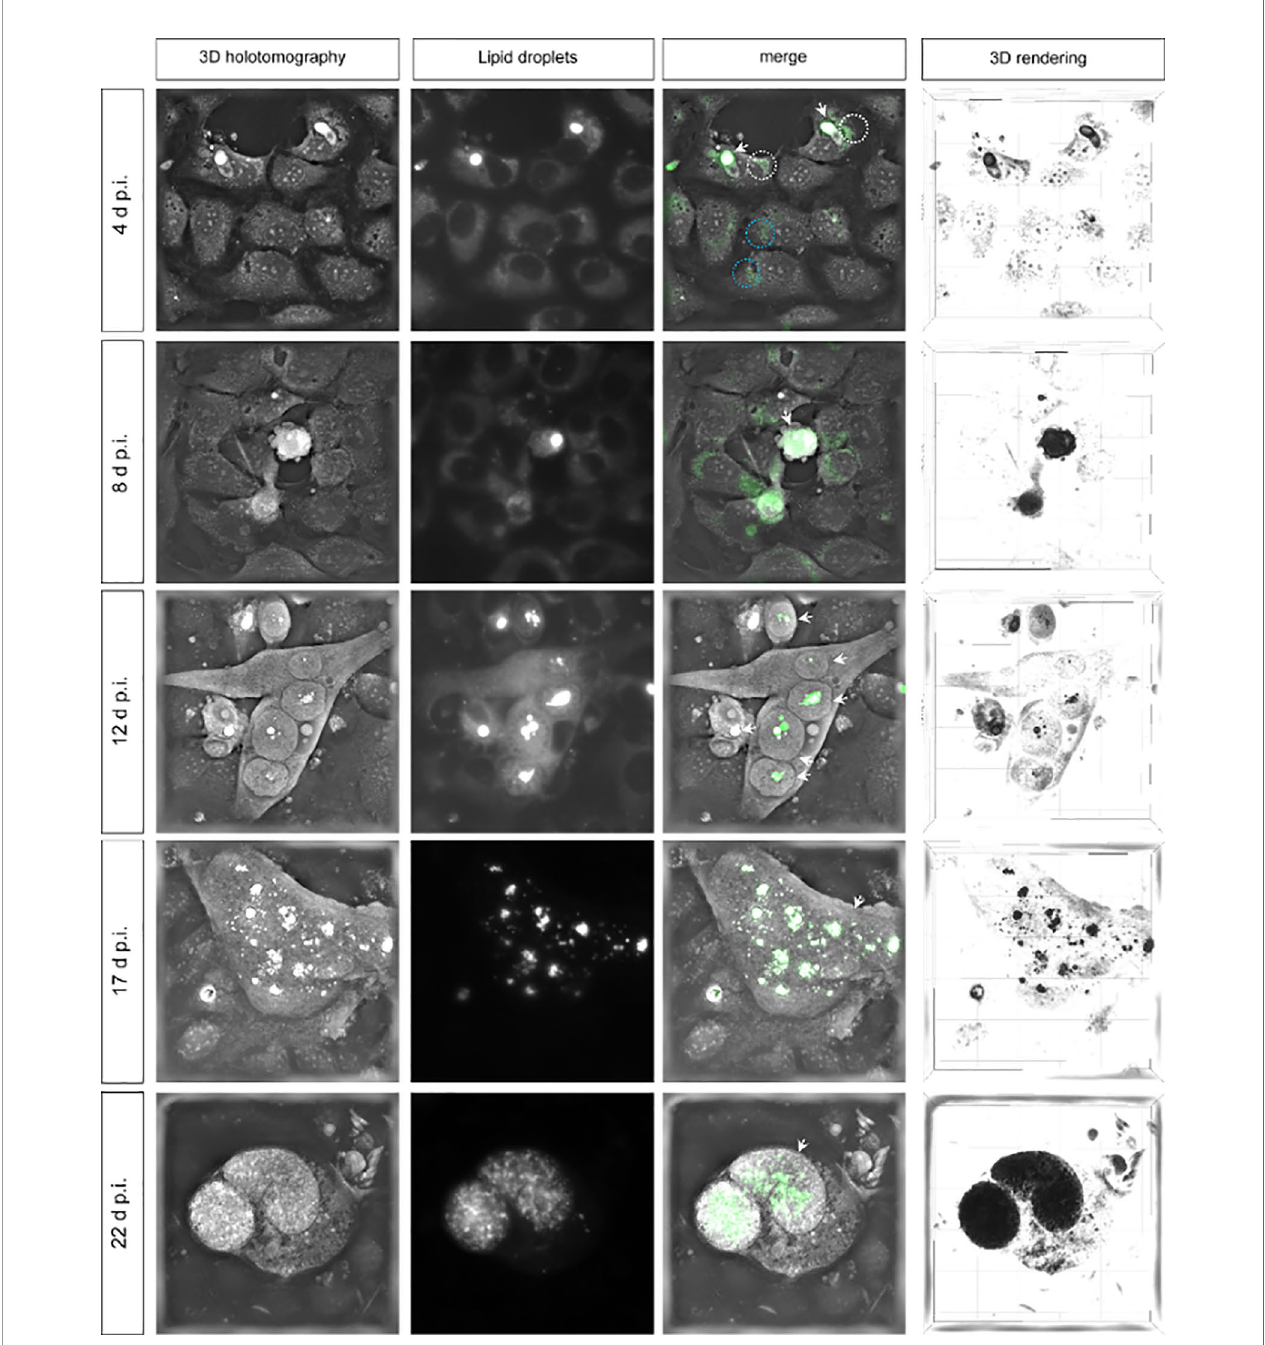
FIGURE 1 | Lipid droplet formation in Eimeria bovis -infected host cells. Live-cell 3D analyses of E. bovis -infected host cells revealed the presence of an increasing number of lipid droplets during macromeront formation. 3D holotomography represents refractive index (RI) images; lipid droplets are stained by LipidSpot ™ (green); merges show co-localization of white structures with higher RI and LipidSpot ™ -stained lipid droplets (green). 3D rendering shows lipid droplets in black in a 3D model. White arrows indicate E. bovis stages; ×600